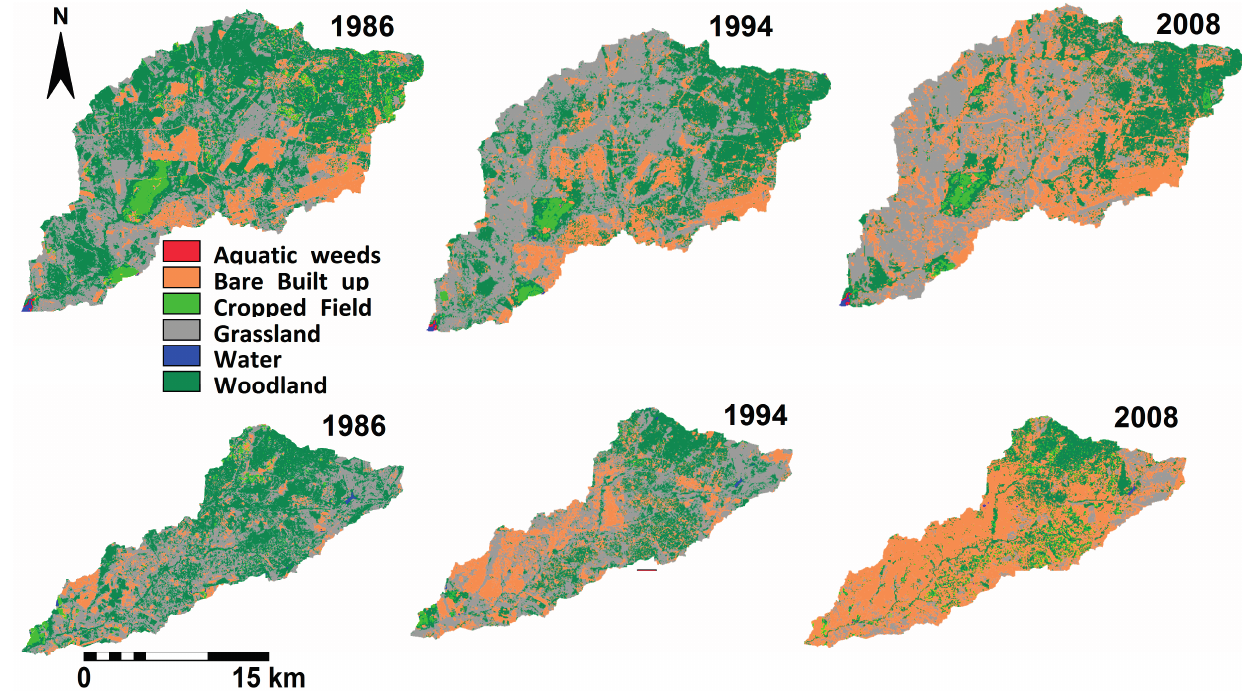
Figure 3. Results of Land cover classification in Marimba ( top panels ) and Mukuvisi ( bottom panels ) catchments for 1986, 1994 and